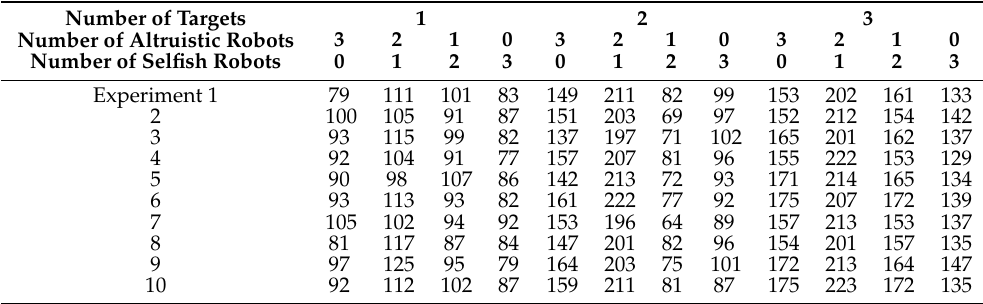
Table 1. Experimental results of autonomous underwater robot swarm game. This table displays the time from the beginning to the completion of each experiment in seconds. The first row of the header gives the number of targets to be searched, and the second and third rows give the number of altruistic and selfish robots.